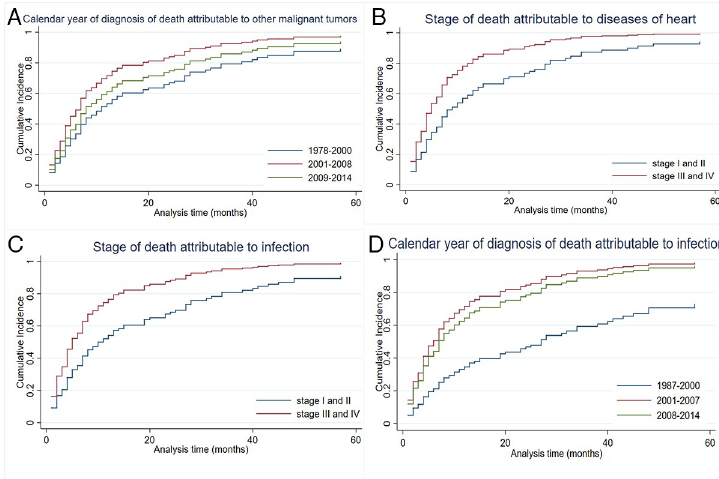
Fig 5. Cumulative incidence plot comparing (A) calendar year of diagnosis attribute to other tumors, (B) Ann Arbor stage of death attribute to disease of heart, (C) Ann Arbor stage of death attribute to infection and (D) calendar year of diagnosis attribute to